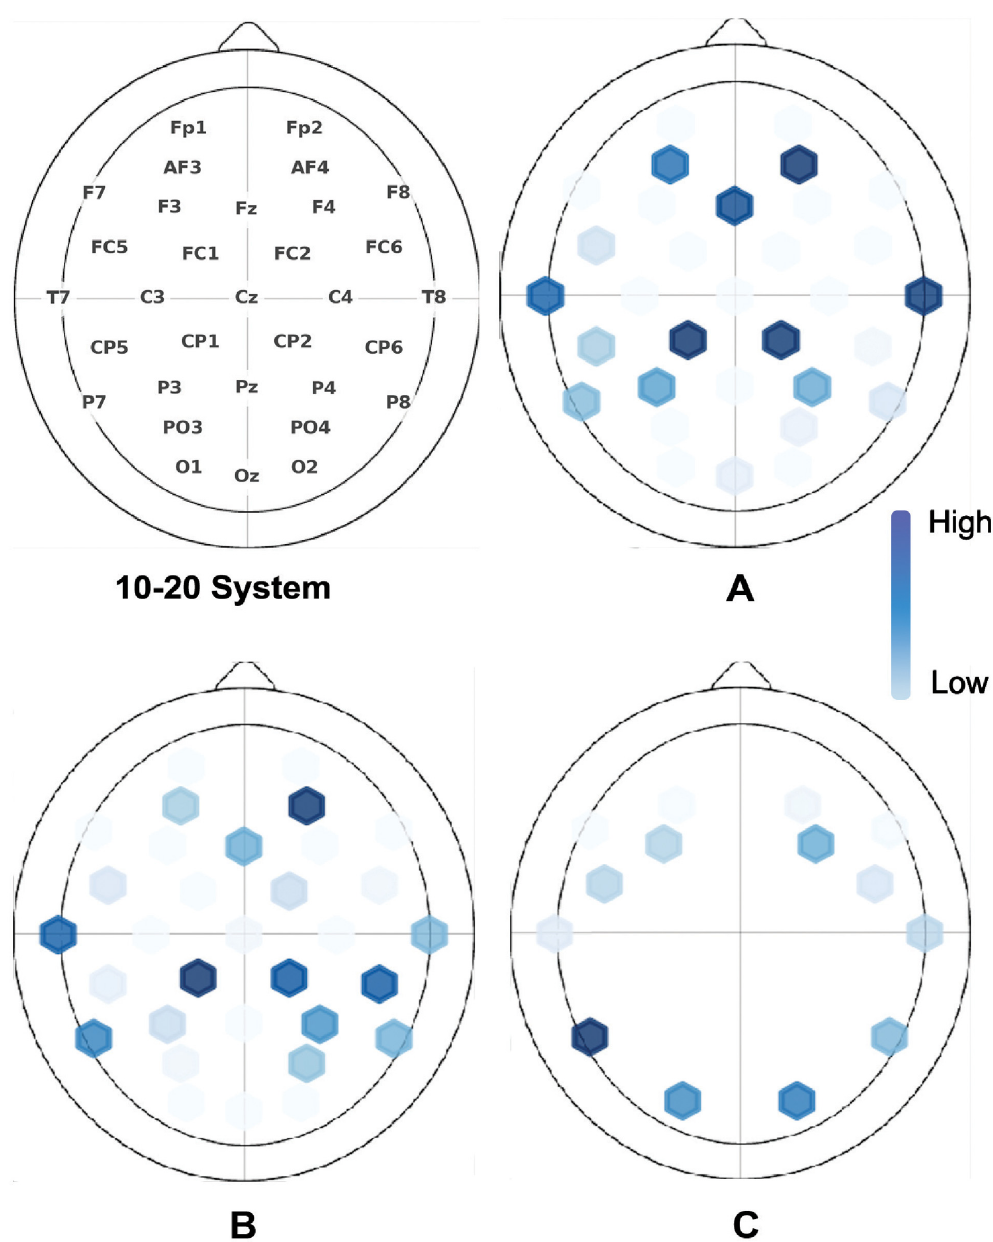
Fig 7. Cross-session channel selection of A) DEAP, B) MAHNOB-HCI, and C) DREAMER. Color intensity represent the frequency of selecting a channel. Top-left is the 10-20 system for EEG electrode placement system.